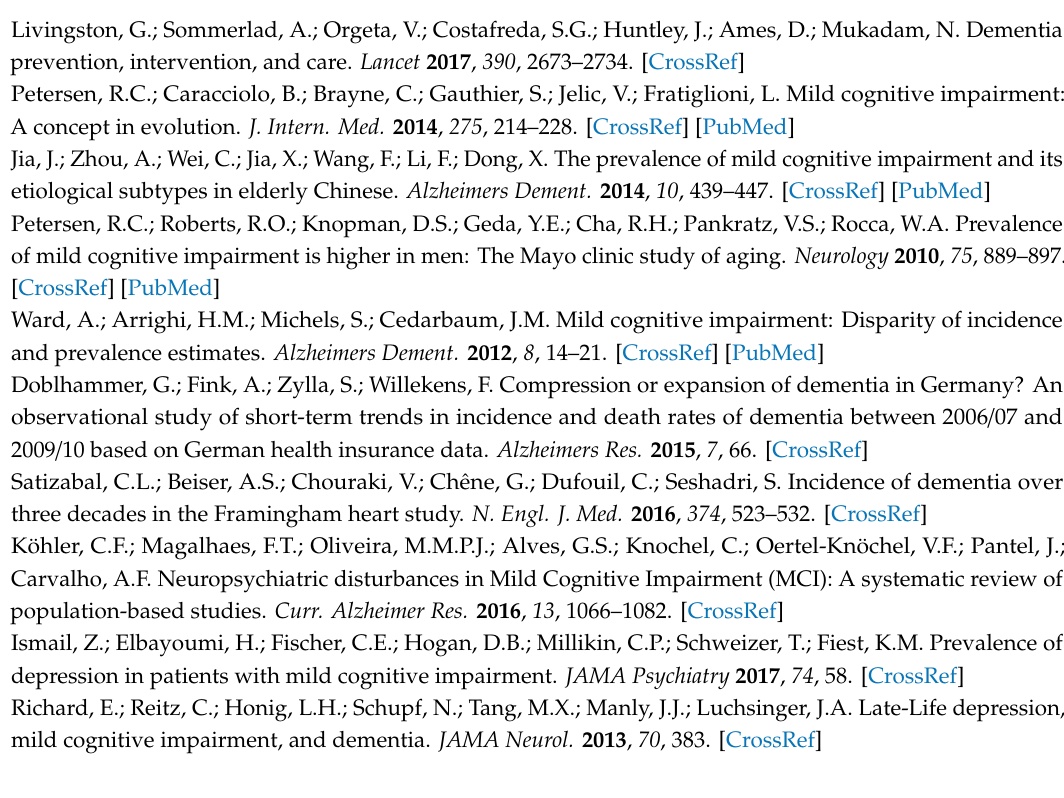
Table S1: Logistic regression analysis for the correlates of the depressive symptoms in patients with MCI. Author Contributions: Conceptualization, D.S., D.S.F.Y. and Q.S.; Data curation, D.S. and Q.S.; Investigation, D.S. and Q.S.; Methodology, D.S., D.S.F.Y. and P.W.C.L.; Writing—original draft, D.S.; Writing—review & editing, D.S.F.Y. and